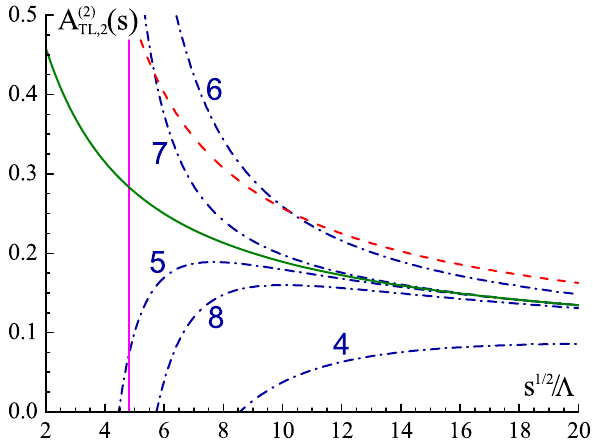
Fig. 7 The function R ((cid:11)) ( s ) [Eq. (10), solid curves], its naive form [Eq. (12), dot-dashed curves], and the re-expanded approximation [Eq. (31), dashed curves] at various loop levels (1 ≤ (cid:11) ≤ 5). Ver- tical solid line marks the boundary of convergence range of the re- √ s /Λ = exp (π/ 2 ) (cid:3) 4 . 81. Numerical labels specify expansion (31) at the loop